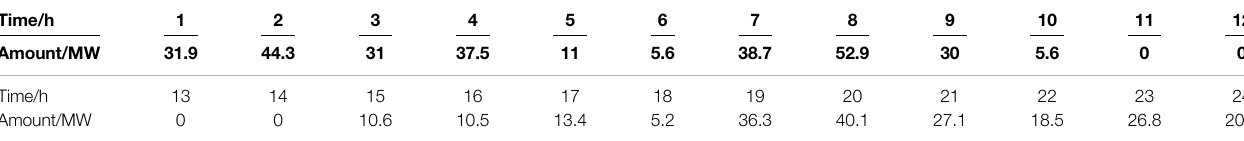
TABLE 1 | Amount of wind power curtailment at each period.